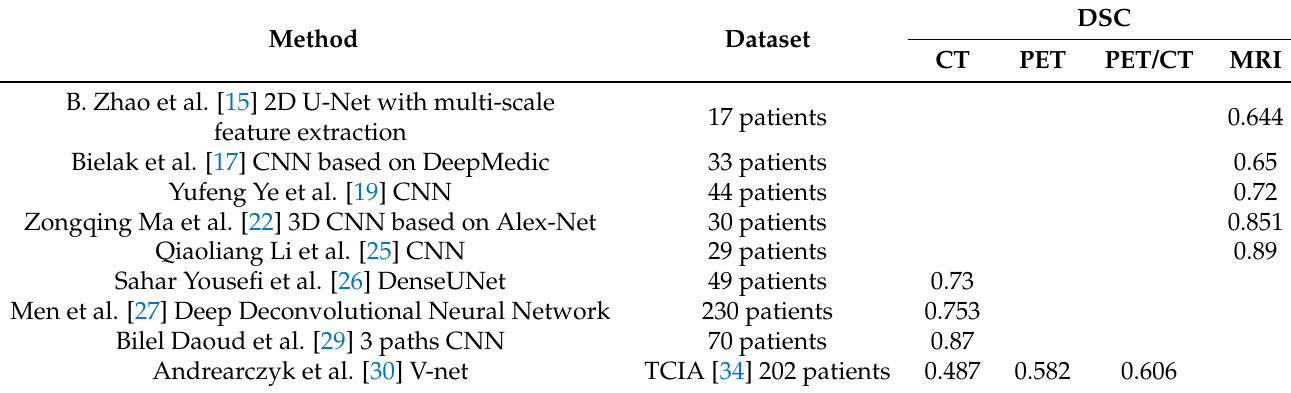
Table 1. Deep learning